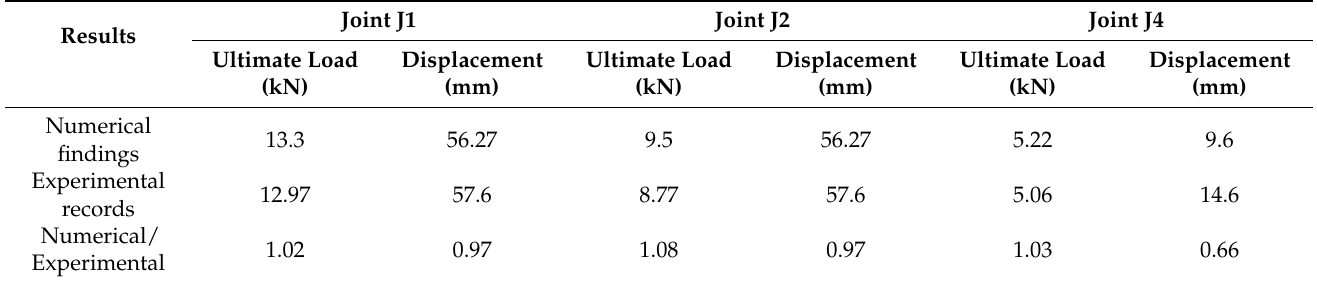
Figure 14. Damage plot of sub-standard joint in combination with the experimental observations.